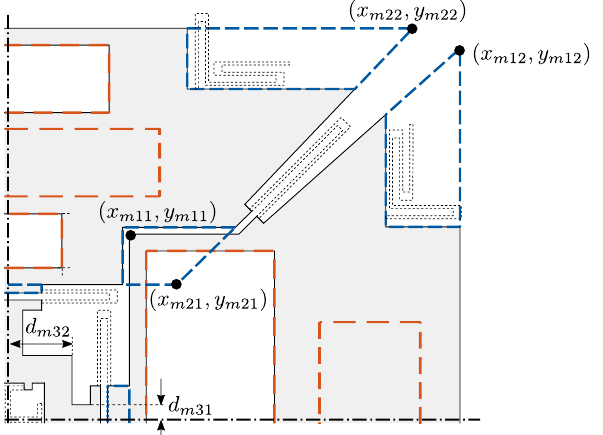
Figure 4. Design variables related to the geometry of the proof masses, removal of over- laps/disconnections in the layout (blue dashed lines), and generation of the space for the electrodes (green dashed lines). Before mirroring, the electrodes have the following dimensions related to one quarter of the structure and are kept at 25 µ m from the borders of the proof masses (cf. nomenclature in Figure 2). D1: 190 µ m × 250 µ m, SD1: 80 µ m × 80 µ m, P1: 225 µ m × 100 µ m, R1: 150 µ m × 150 µ m, Y1: 150 µ m × 100 µ m. Redrawn from [29].